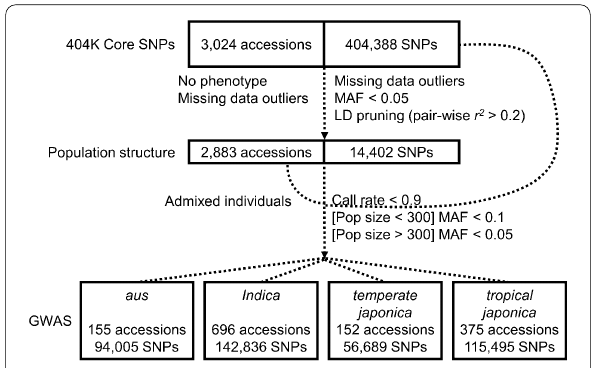
Fig. 1 Workflow of 3K‑RGP genotypic data preparation. The short sentences next to the dash lines indicate criteria to remove accessions or SNPs from previous data set. After population structure analysis, while the individuals were thinned, we went back to the 404K core SNPs to filter SNPs for